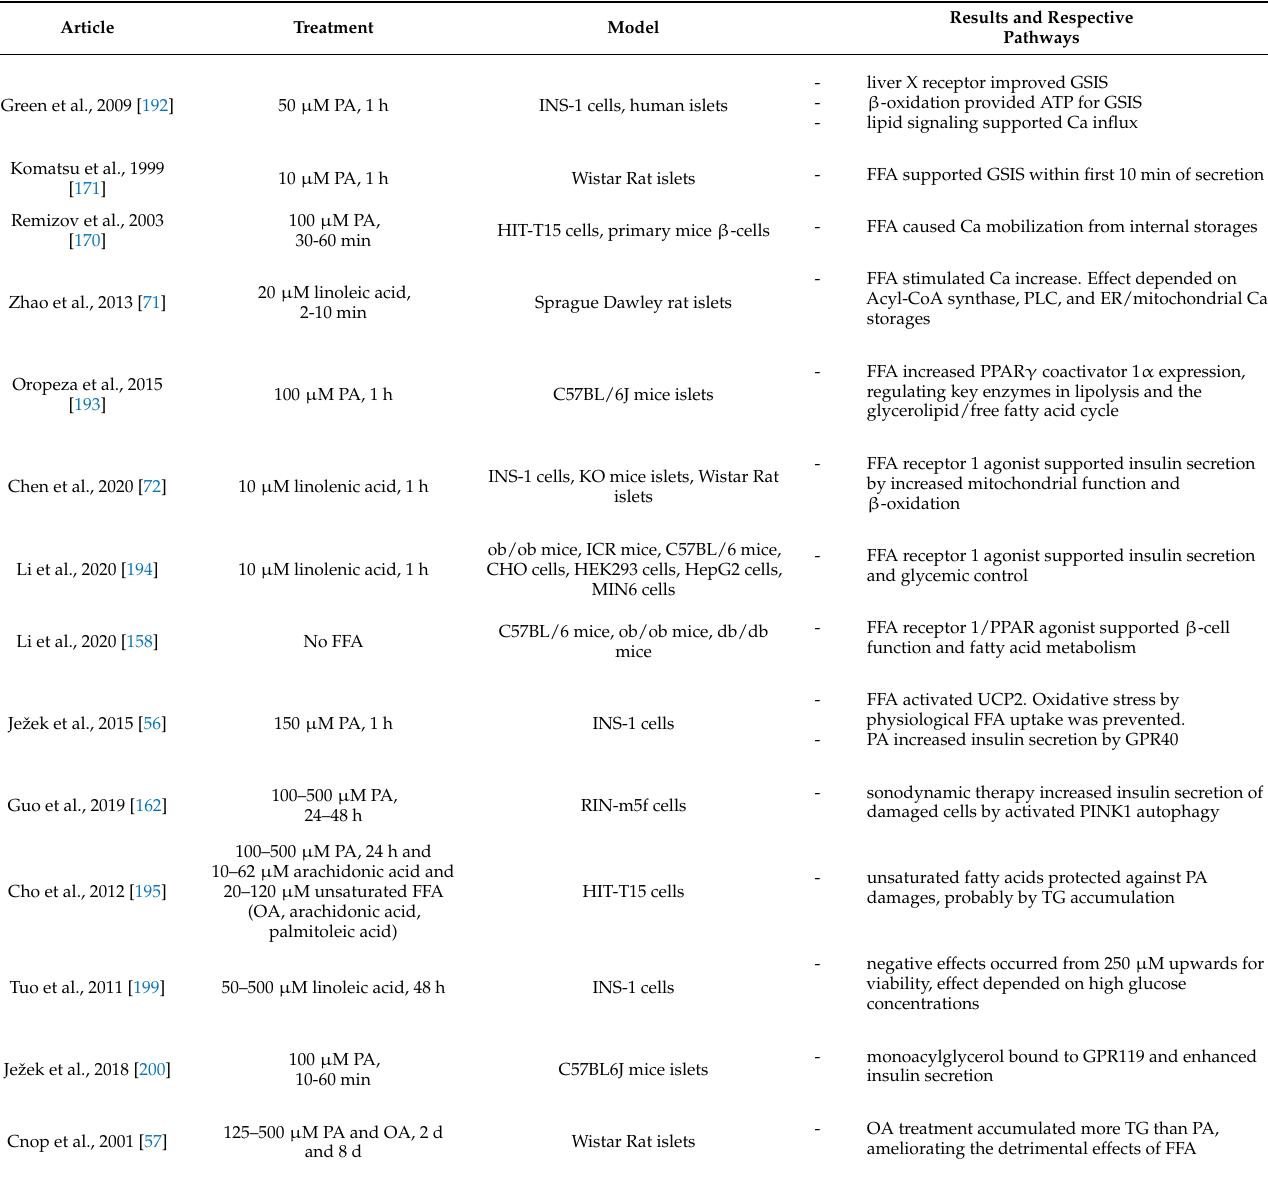
Table 6. Summary of metabolic effects of FFA treatment and respective pathways. Palmitic acid (PA). Insulinoma (INS- 1). Glucose-stimulated insulin secretion (GSIS). Adenosine triphosphate (ATP). Calcium (Ca). Free fatty acids